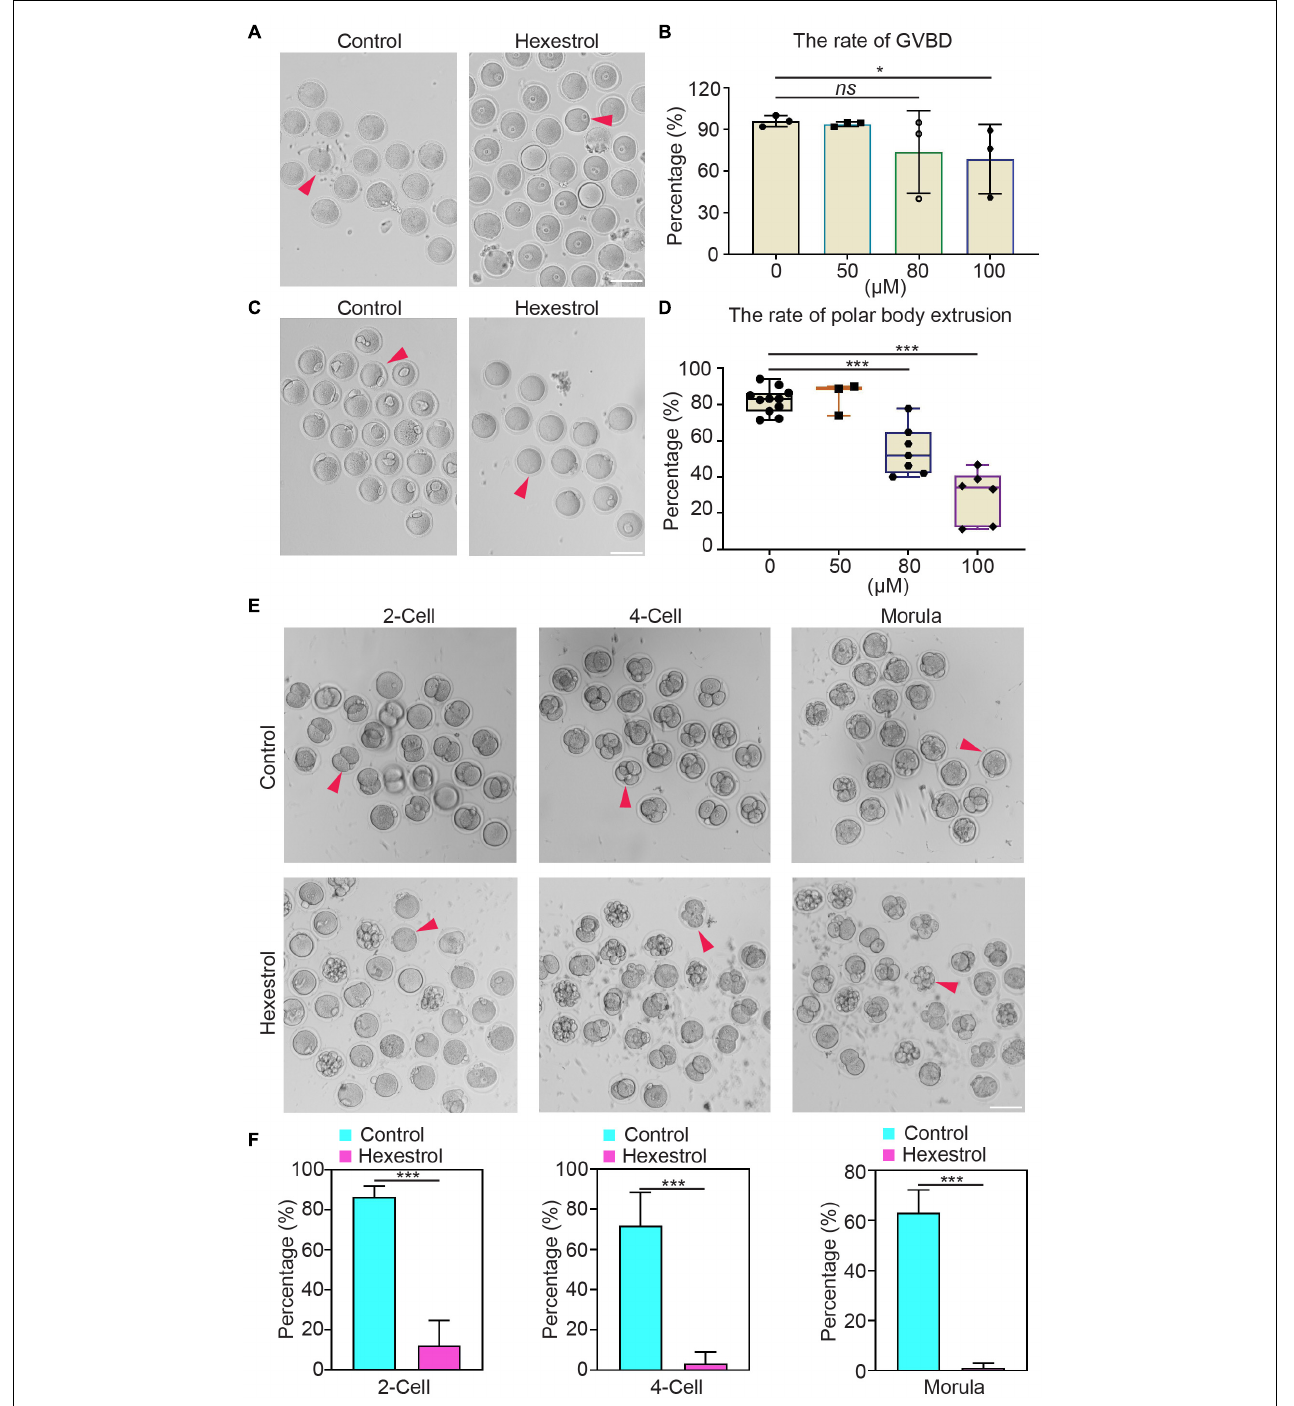
FIGURE 2 | HES impairs oocyte maturation and early embryonic development. (A) Representative images of germinal vesicle breakdown oocytes in control and HES-exposed oocytes. Scale bar, 100 µ m. (B) Percentage of germinal vesicle breakdown was quantified in control and in oocytes exposed to different concentrations of HES (50, 80, and 100 µ M). ns, P > 0.05, and * P < 0.05. (C) Representative images of first polar body extruded-oocytes from control and HES-exposed groups. Scale bar, 100 µ m. (D) Rate of polar body extrusion was recorded in control and HES-exposed groups. *** P < 0.001. (E) Representative images of fertilized eggs in control and HES-exposed group. Scale bar, 100 µ m. (F) Early embryonic development was recorded in control and HES-exposed group. *** P < 0.001. Data are represented as mean ± SD from at least three independent experiments.